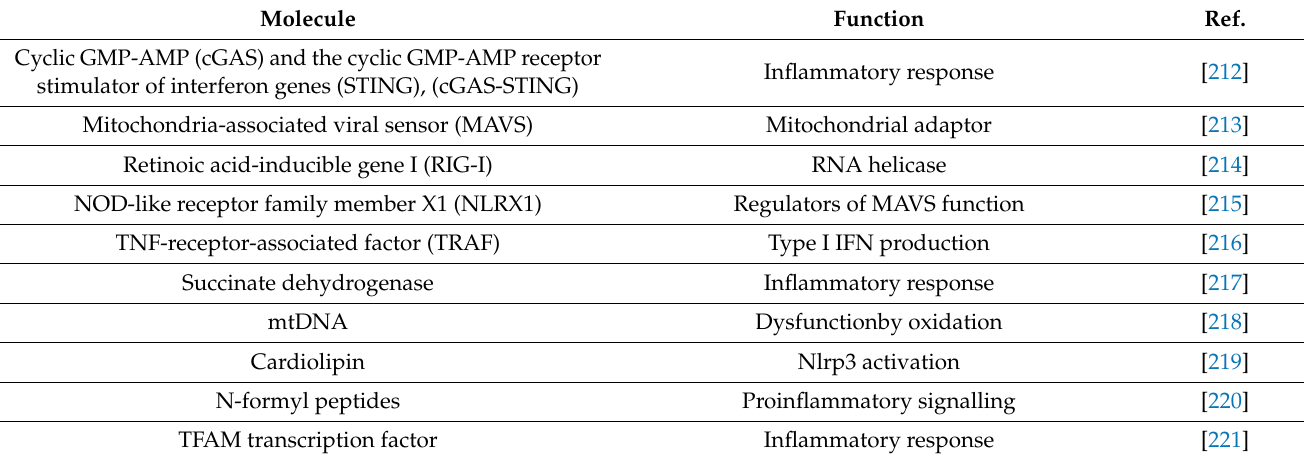
Table 2. Proteins involved in mitochondrial dysfunction in imflammaging. Molecule Function